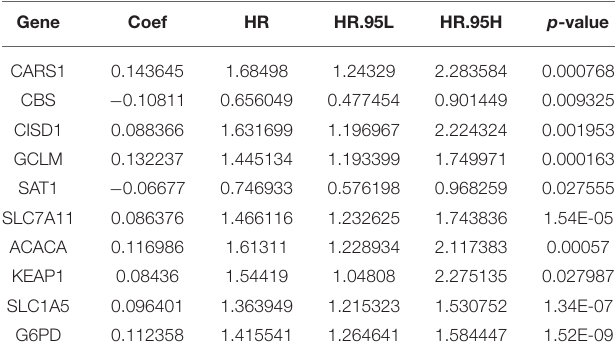
TABLE 1 | The 10 immune-related hub genes used to compute IRGPI risk